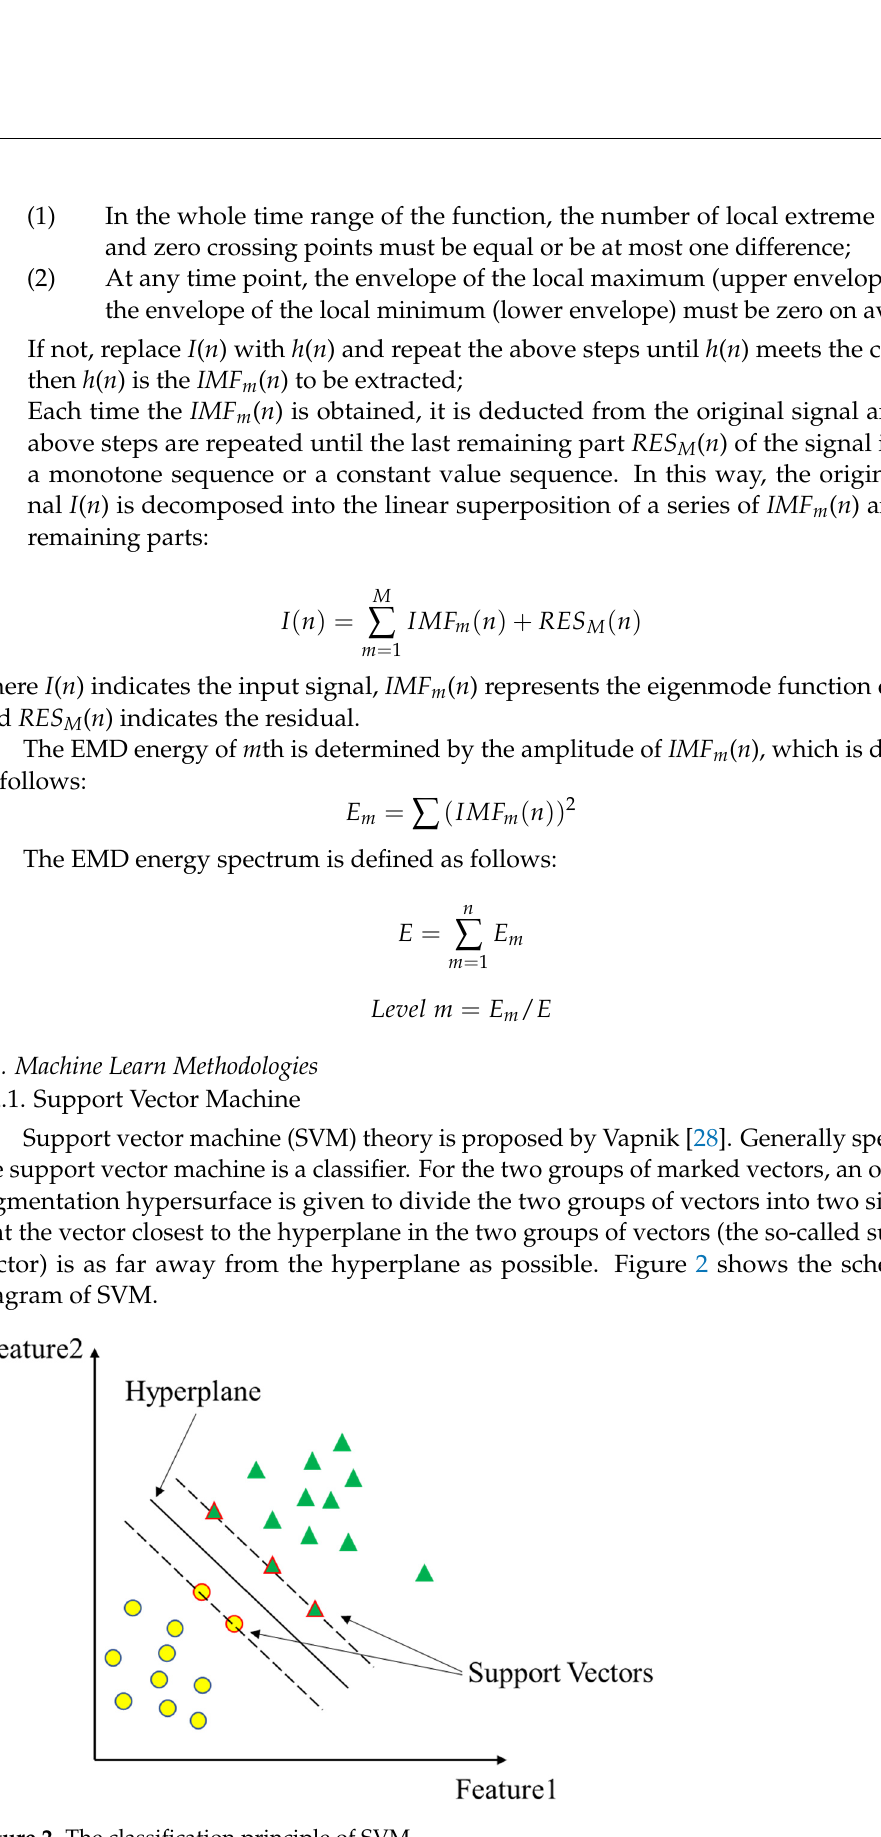
Figure 2. The classification principle of SVM.